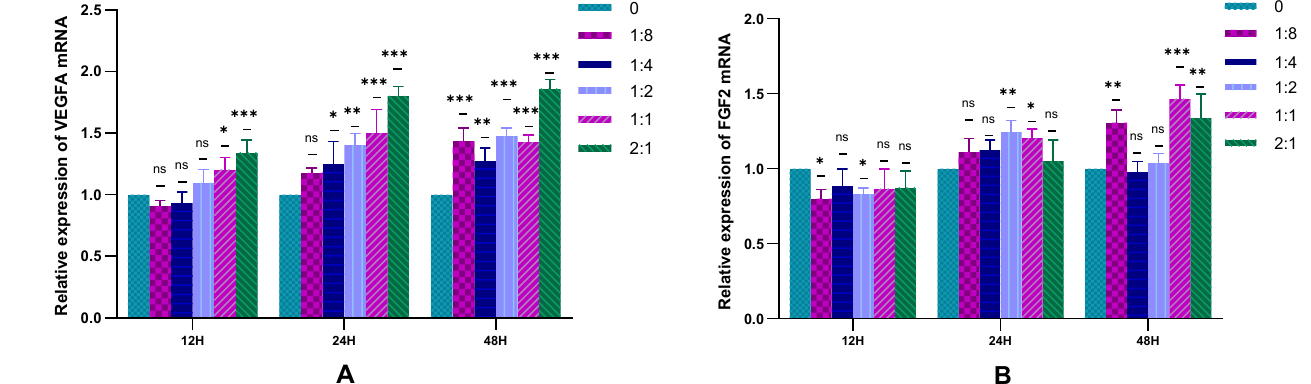
Figure 6. In the cell co-culture system, the RT-qPCR statistical diagram of HSFs VEGFA and FGF2